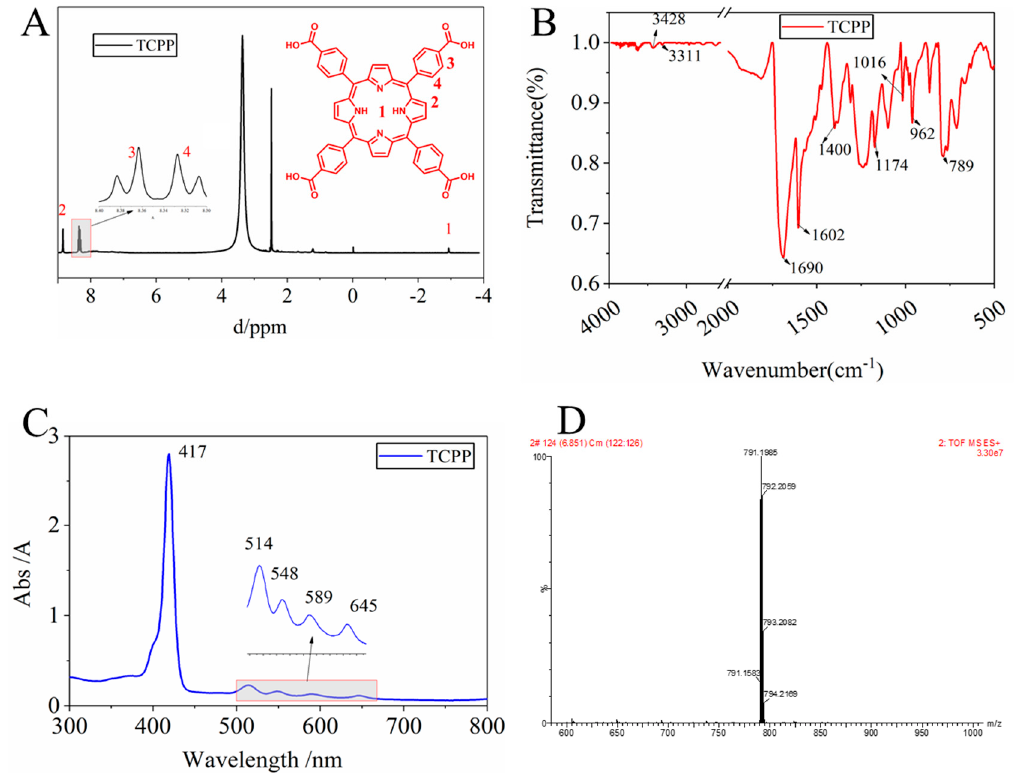
Figure 2. Characterization of as-prepared TCPP, ( A ) 1 H NMR, ( B ) FTIR spectra, ( C ) UV spectra and ( D ) MS spectra.